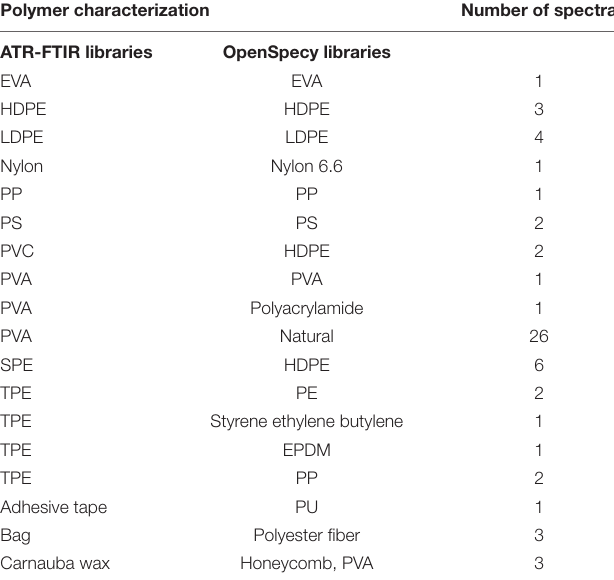
TABLE 2 | Cross-referencing of spectra identified by our instruments’ and in-house libraries against the OpenSpecy libraries. Polymer